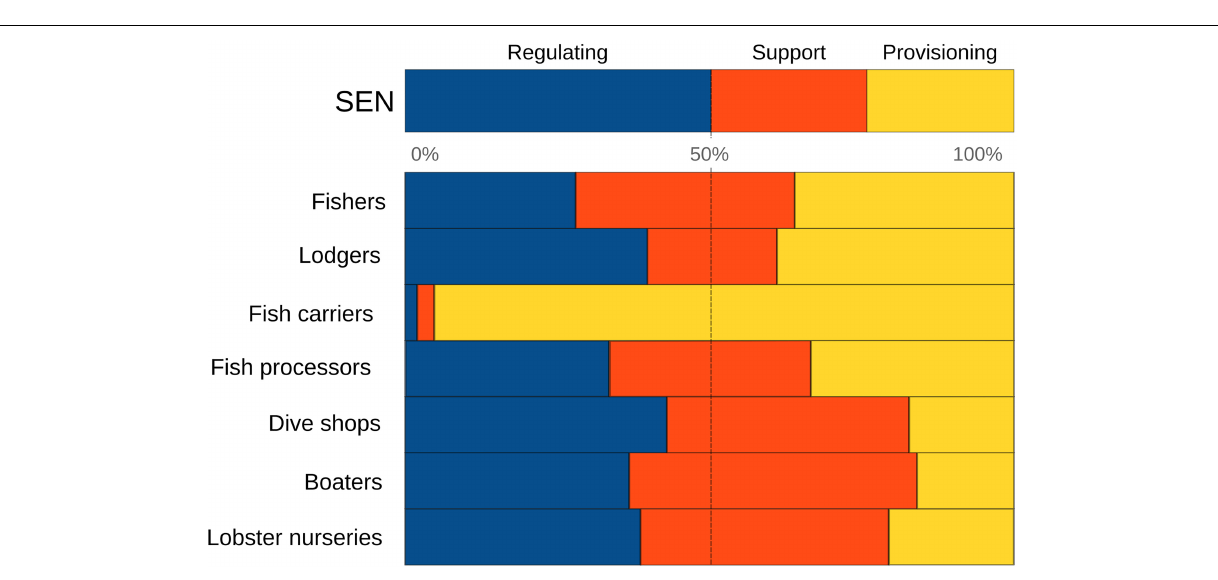
FIGURE 4 | Relative importance of the ecosystem services included within the socio ecological network (SEN) based on the amount of benefits flowing through the SEN and received by each stakeholder